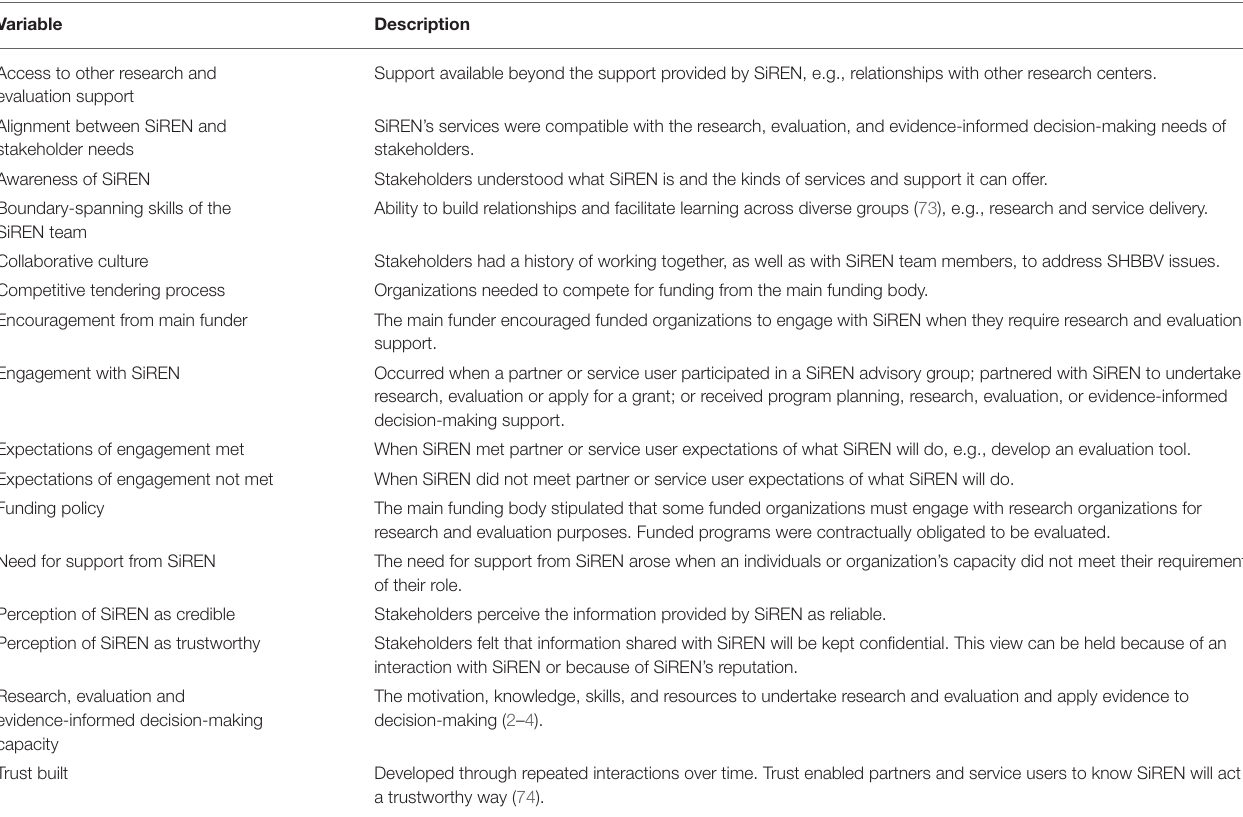
TABLE 2 | A description of variables that influence engagement with SiREN.